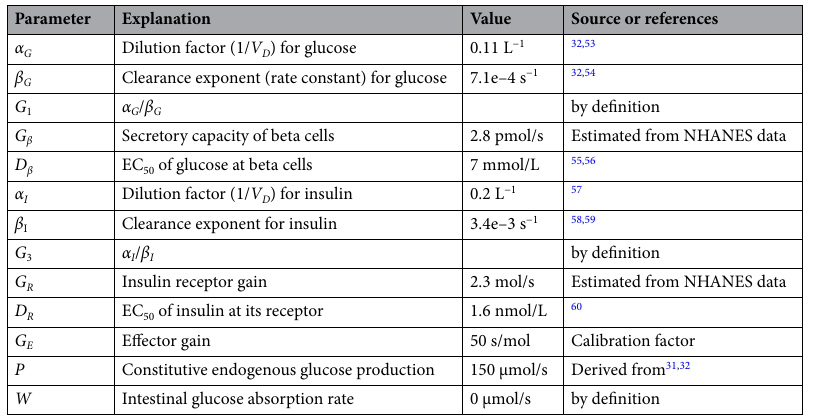
Table 1. Parameters used for predicting the steady state and for computer